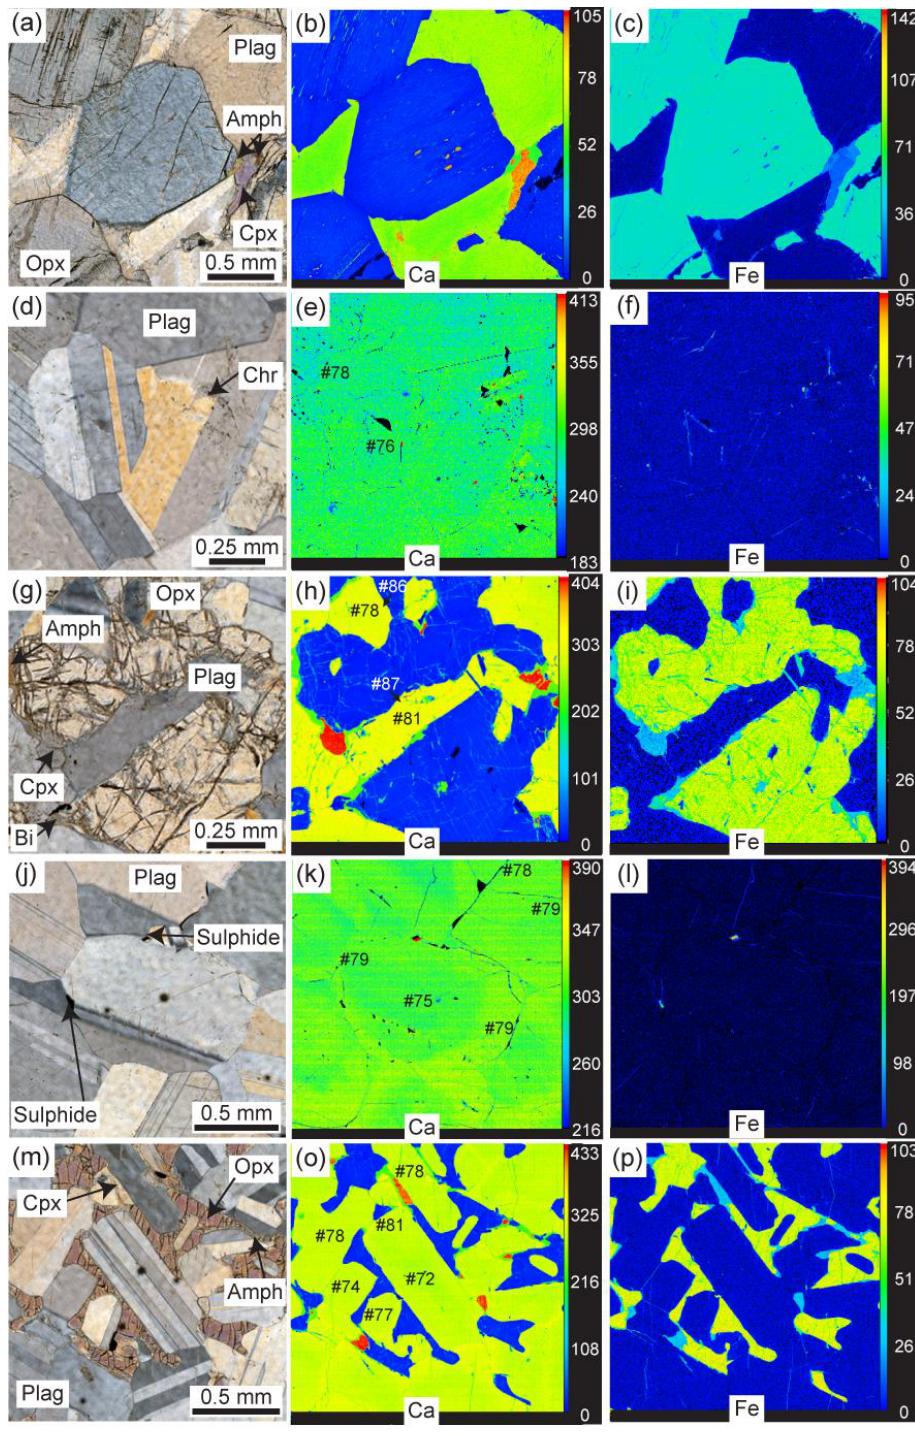
Figure 9. Ca (centre) and Fe (right) element maps for ( a – c ) Merensky feldspathic orthopyroxenite; ( d – f ) HW 1 leuconorite plagioclase; ( g – i ) Orthopyroxene within HW 1 leuconorite; ( j – l ) HW 2 poikilitic anorthosite plagioclase; and ( m – p ) HW 2 orthopyroxene oikocryst with plagioclase chadacrysts. Anorthite contents are marked by #. All photomicrographs (left) were taken under differential interference contrast (DIC) as an approximation of circularly polarised light; scale is identical to element maps of the same area. Opx = orthopyroxene; Cpx = clinopyroxene; Chr = Cr-spinel; Plag = plagioclase; Bi = Biotite; Amph = amphibole. Larger versions of these maps are available in the online supplementary material (Figures S1 – S5).